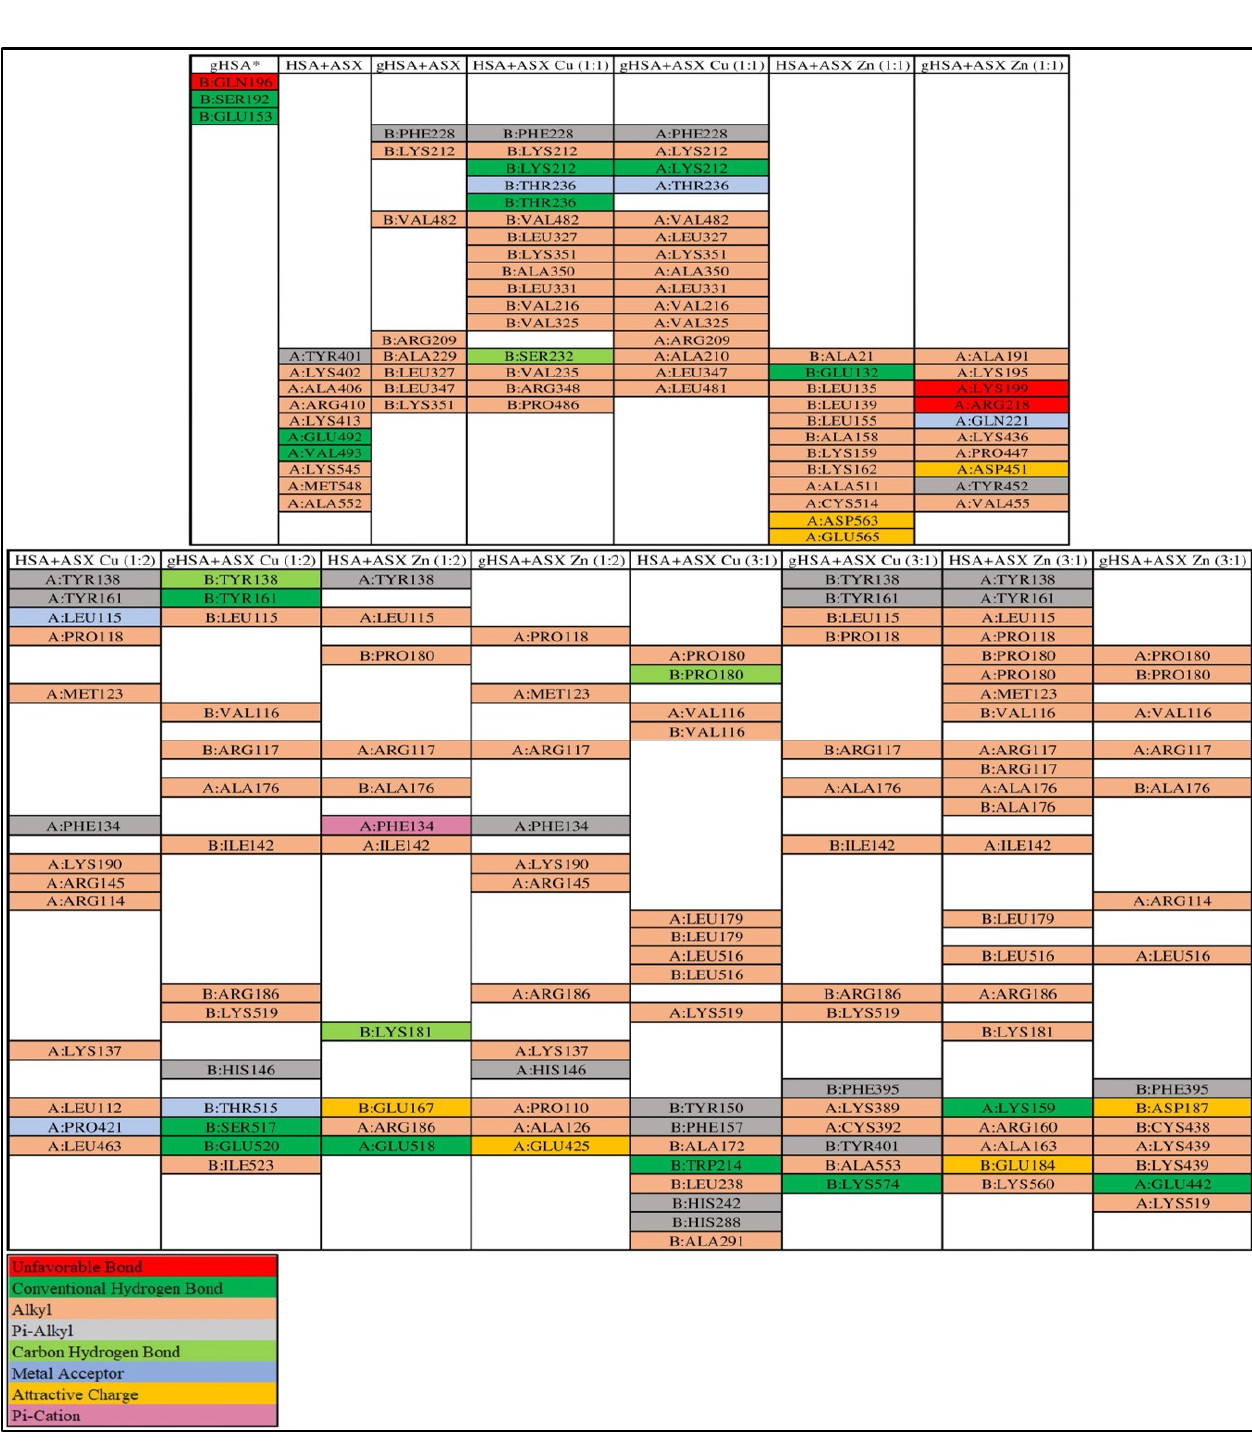
Figure 10. Binding sites for ASX/ASX-metal ions with HSA and gHSA (*HSA complex with glycation agent).